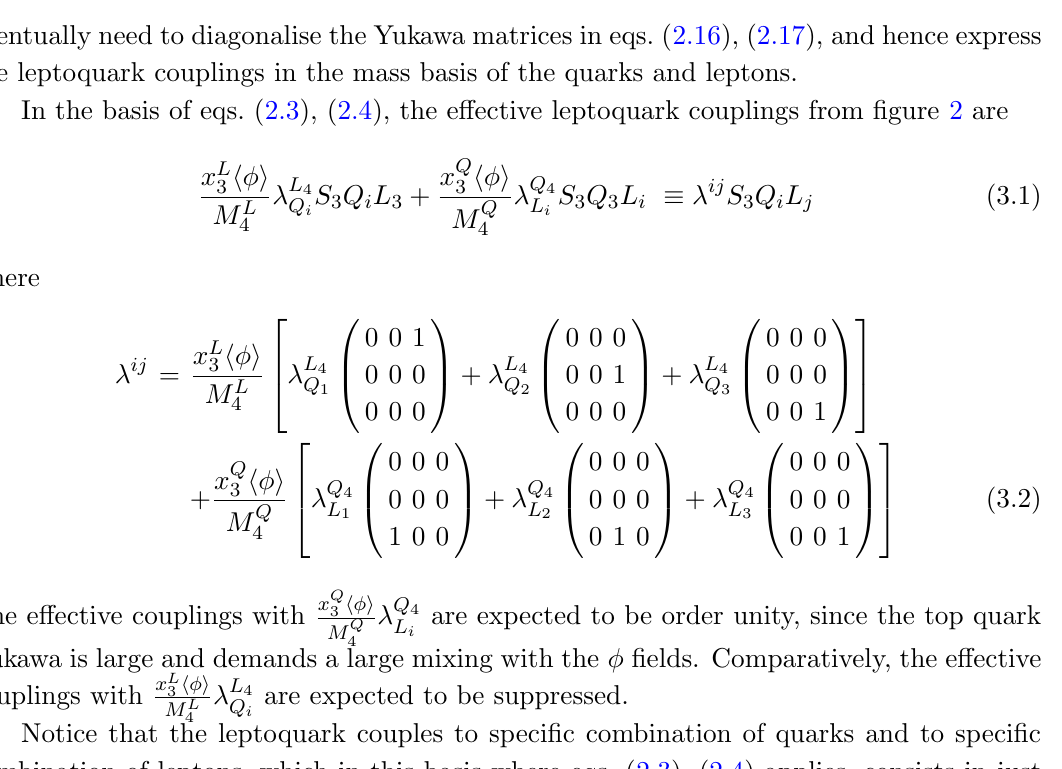
couplings in the mass insertion 3